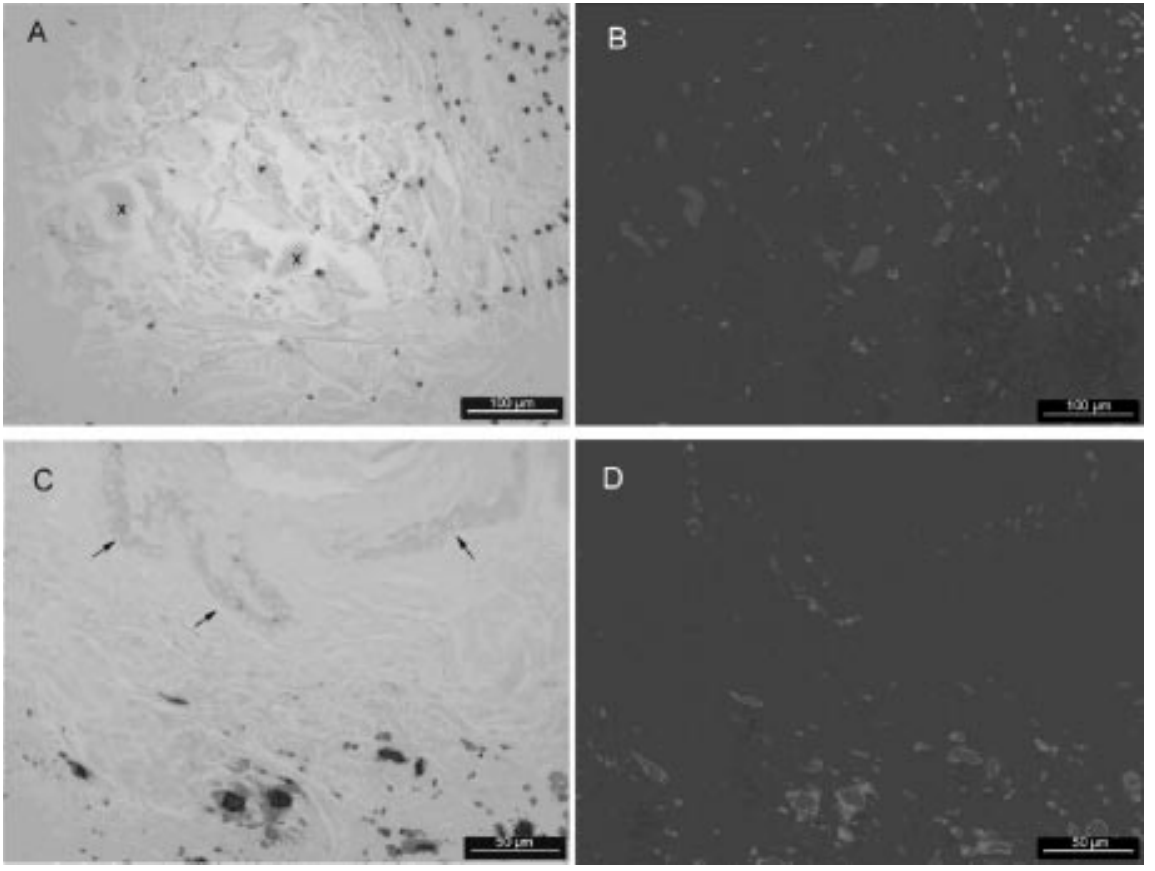
Fig. 2. Specificity and accuracy of the segmentation. Two examples with original true colour pictures showing red immunostained particles (A and C) and the result of cell-independent segmentation in the grey scale picture after colour translation, linear combination and automated thresholding marked by red overlay colour (B and D). Note that unwanted detection of faint background staining (x in A) and brown endogeneous melanin pigment ( " in C) could be